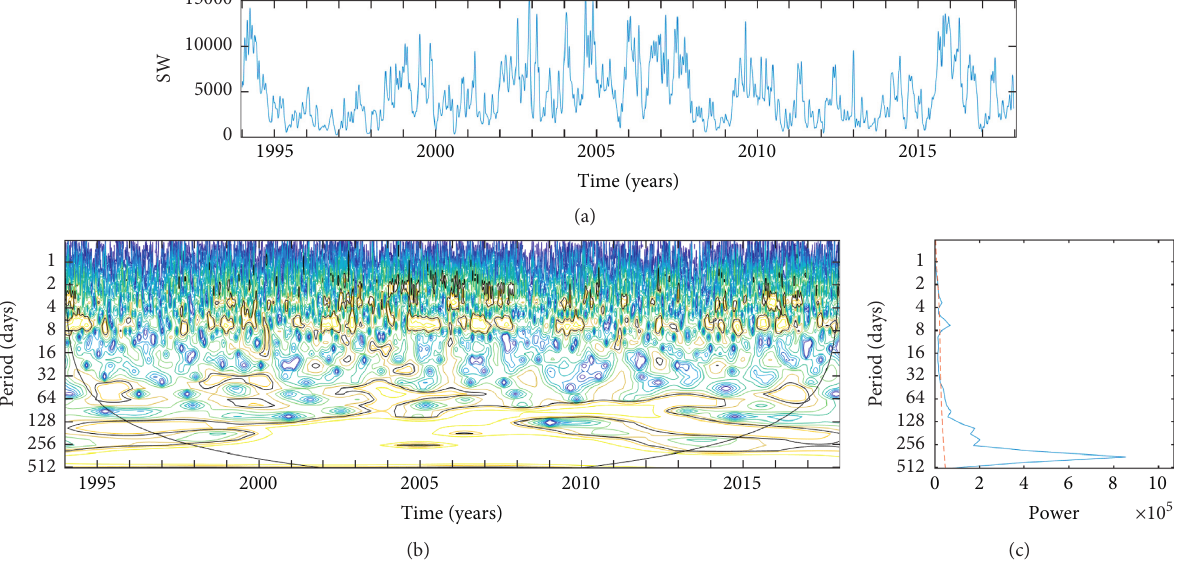
Figure 5: (a) The scale-average time series of daily solar wind speed, (b) the wavelet spectrum, and (c) the global wavelet spectrum.